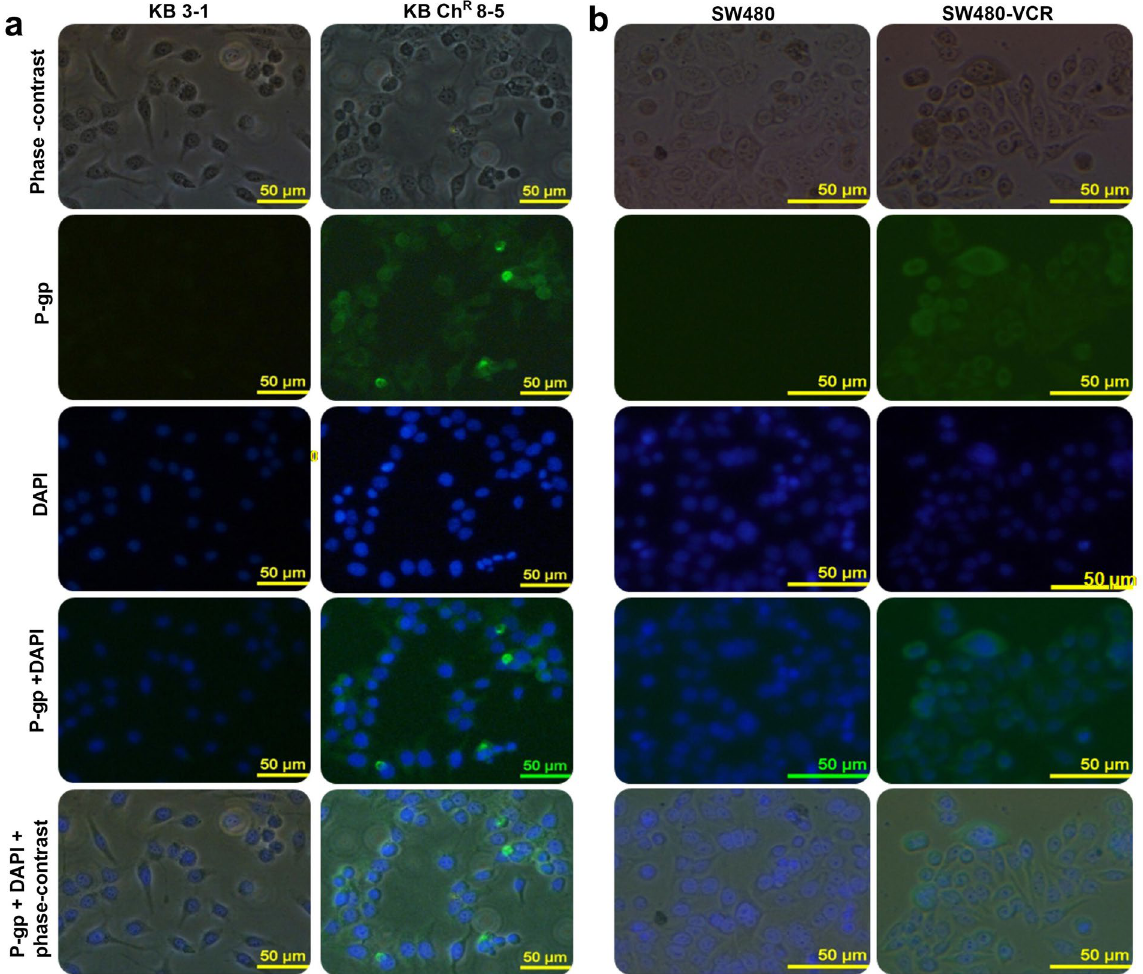
Figure 9. P-gp localization by immunofluorescence microscopy in ( a ) parental KB 3–1 and resistant KB Ch R 8–5 cells and ( b ) parental SW480 and resistant SW480-VCR cells. The phase contrast, P-gp (green) and DAPI nuclear counter stain (blue). High levels of P-gp protein was localized to the plasma membrane of resistant cell line, KB Ch R 8–5 and SW480-VCR